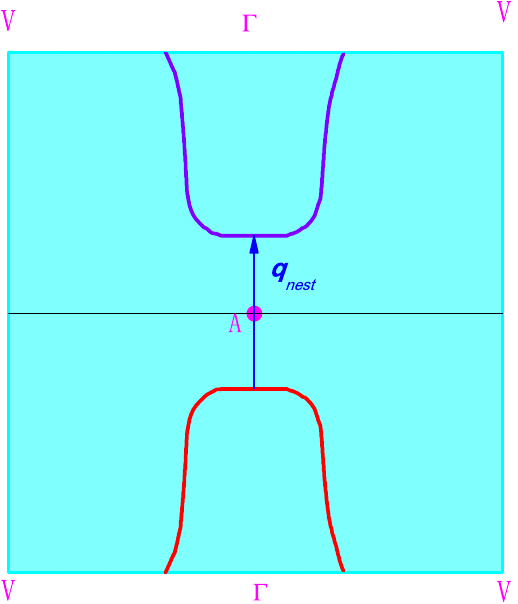
Figure 4. Electronic Structure. Calculated Fermi surface of Fe 3 Ga 4 on a (010) plane through Γ with the proposed nesting illustrated. Here Γ = (0 0 0), A = (0 0 1/2) and V = (1/2 0 0). Red and violet are sheets of Fermi surface belonging to adjacent Brillouin